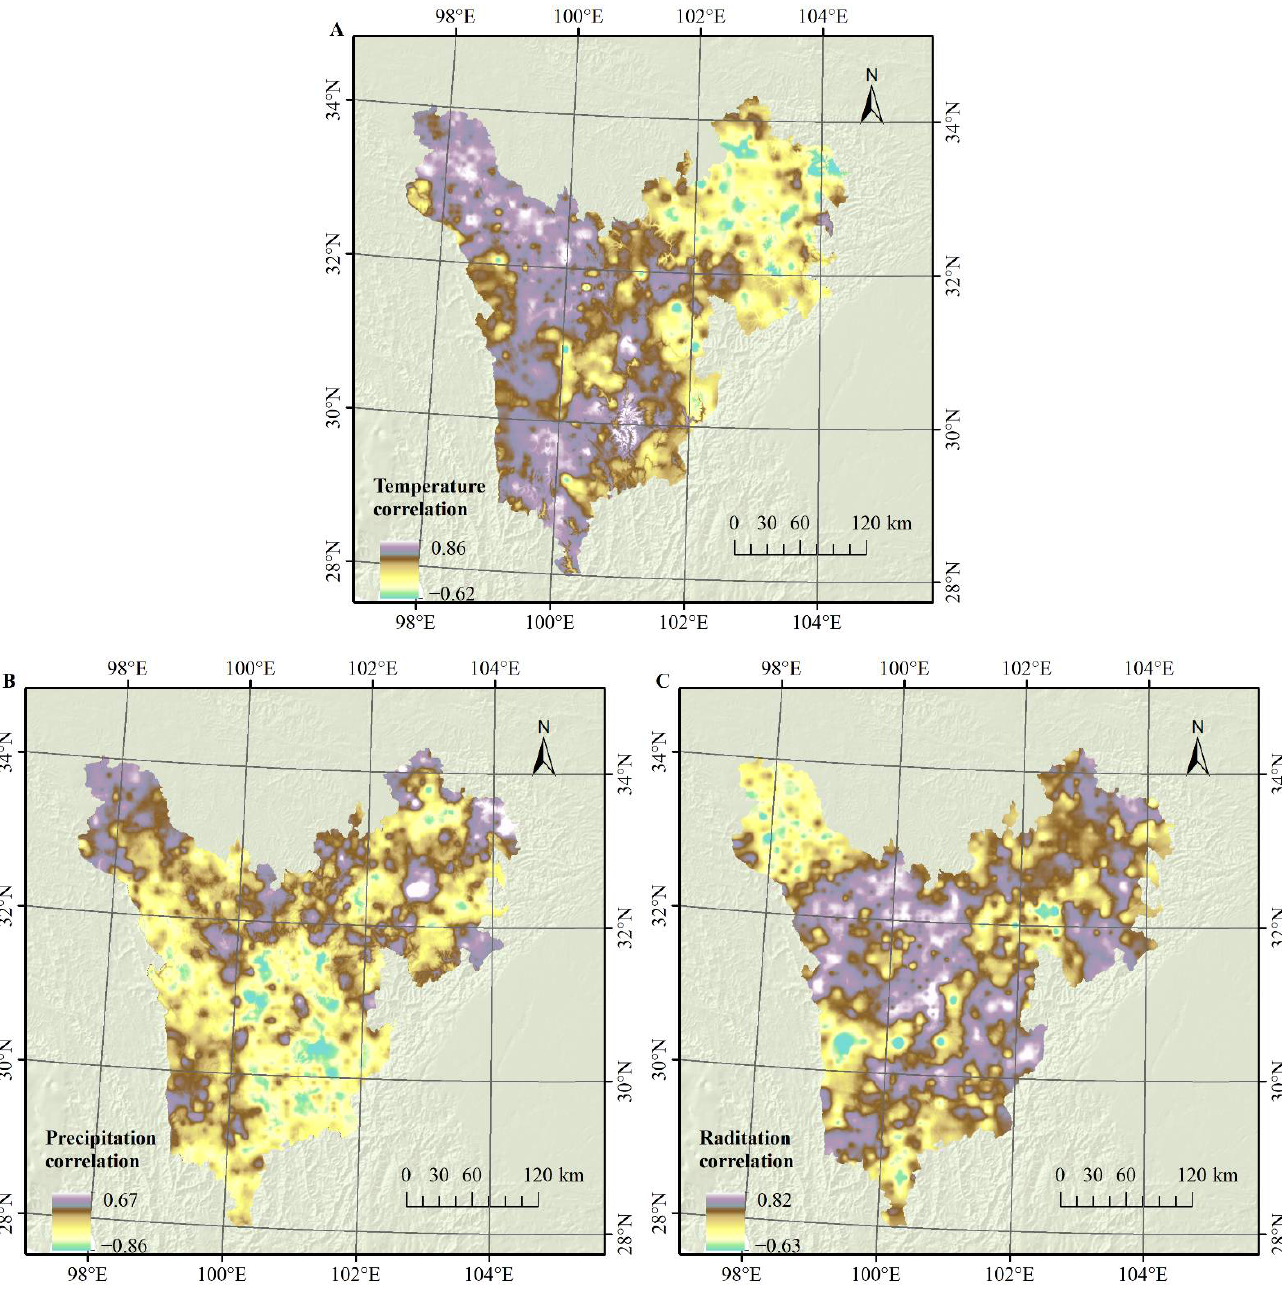
Figure 10. Correlation of temperature ( A ), precipitation ( B ), solar radiation ( C ), and VNPP.